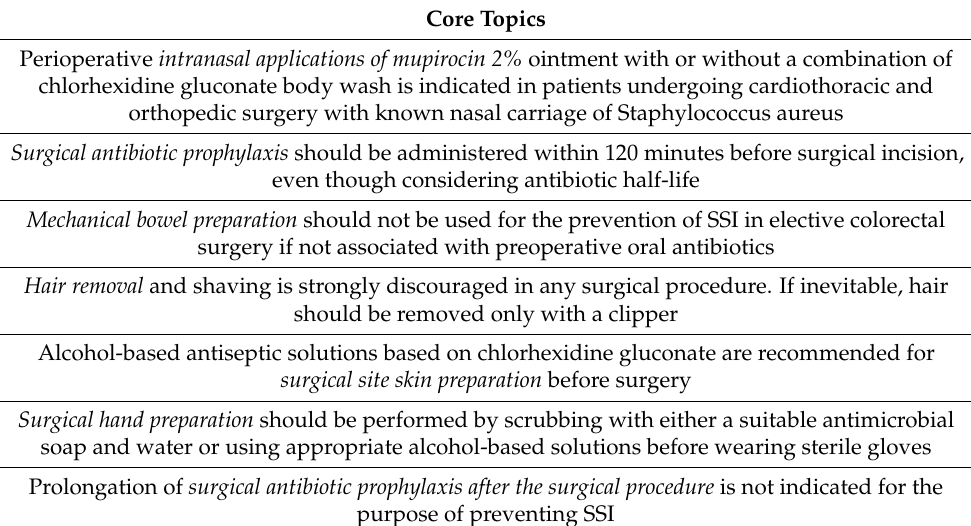
Table 3. WHO strong recommendations for the prevention of surgical site infection *. Core